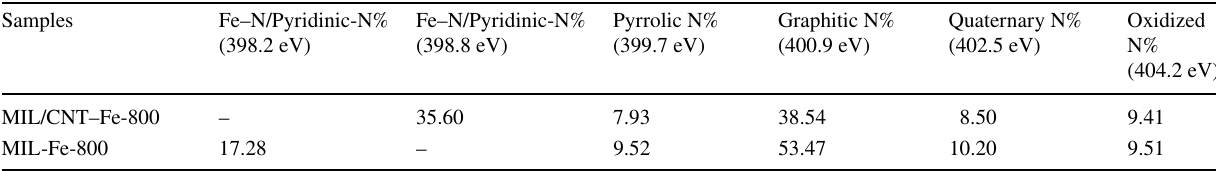
Table 2 Contents of different N1 s species in the prepared catalysts Samples